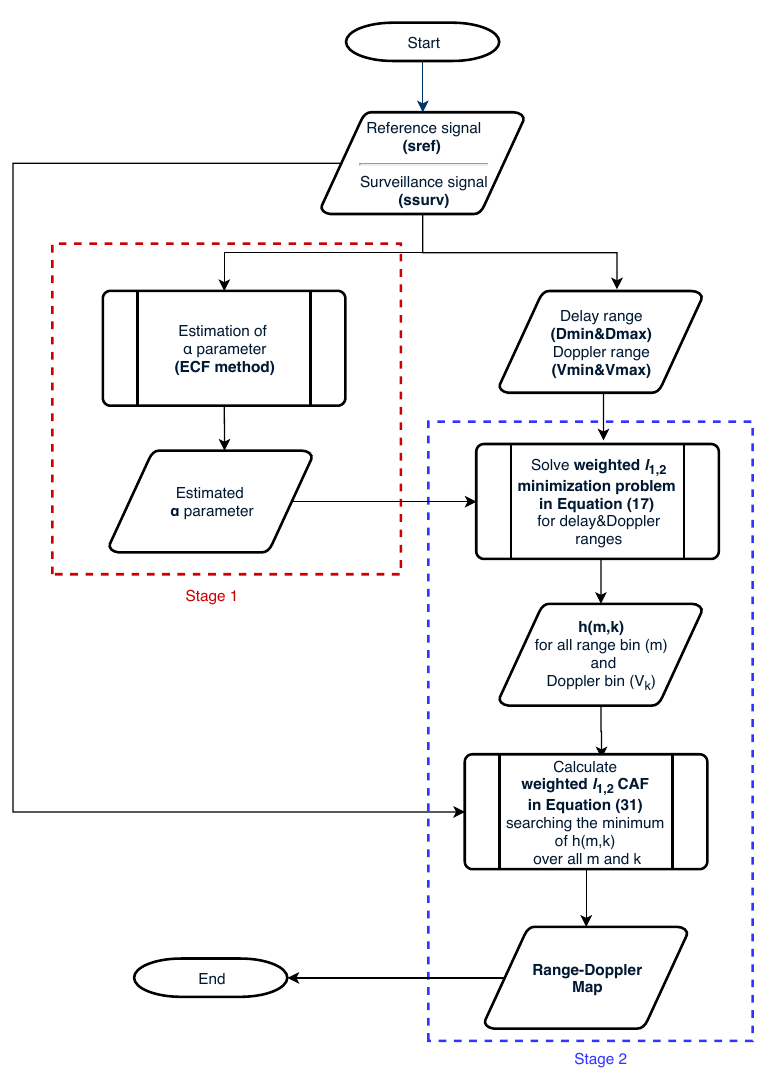
Figure 6. Flowchart of the proposed